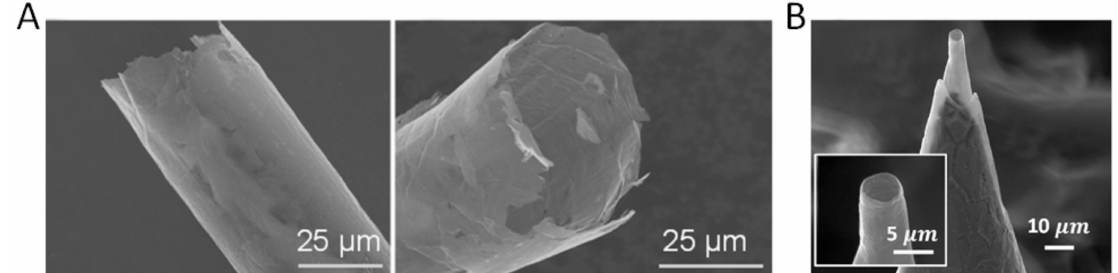
Figure 6. Graphene ring-cathode field emitter. ( A ) Macroscopic, freestanding, and tubular graphene architectures. Reproduced with permission from [81], Copyright ACS publications, 2015; ( B ) A few-layer graphene ring-cathode field emitter. Reproduced with permission from [82], Copyright Elsevier,